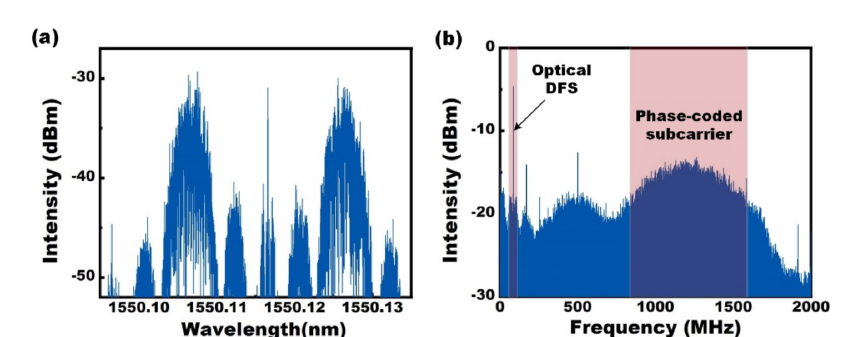
Figure 7. ( a ) Optical spectrum of the transmitted lightwave. ( b ) Spectrum of the beat signal, in which an 85-MHz optical DFS is simulated by an acoustic-optic modulator.